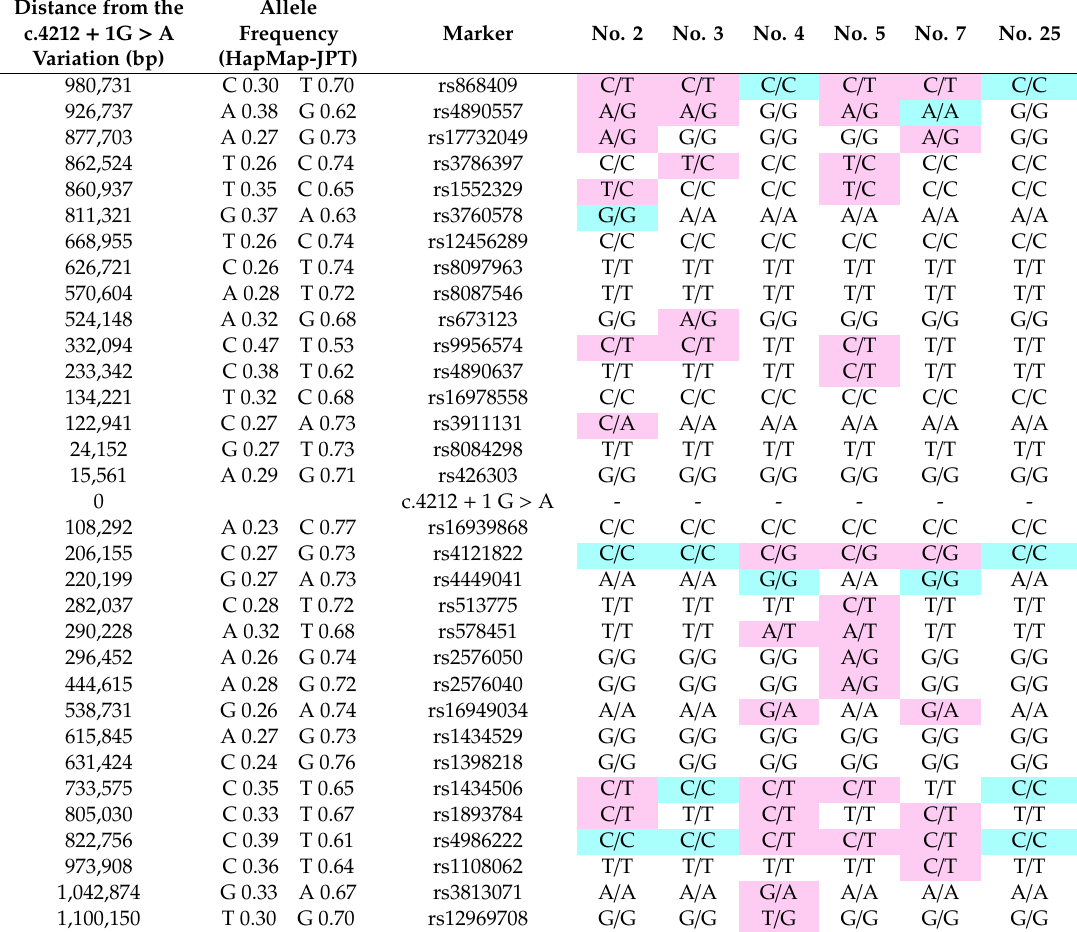
Table 4. Haplotype analysis of LOXHD1 recurrent variation, c.4212 + 1G >